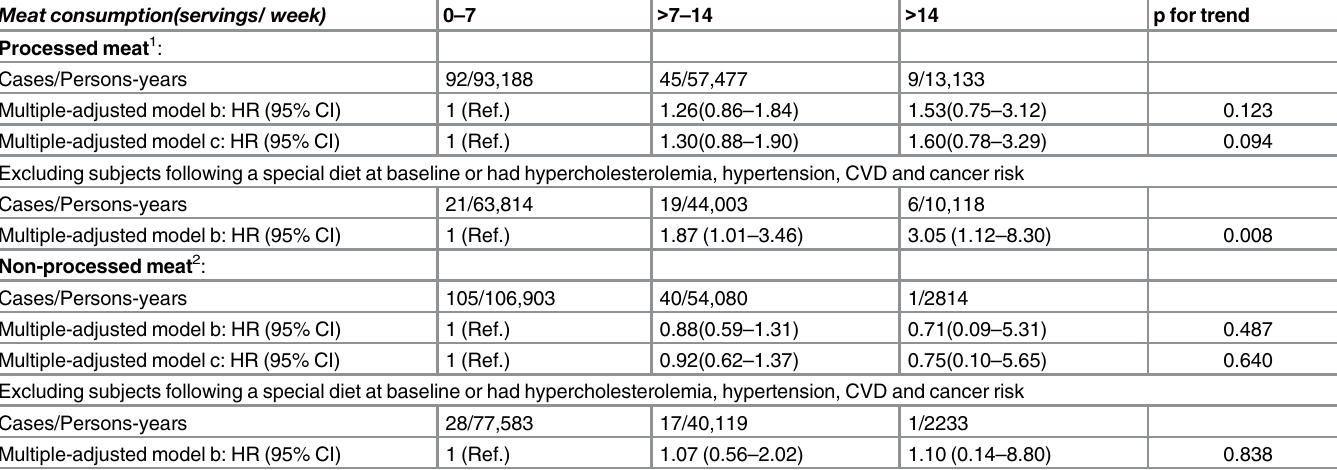
Table 3. HR and 95% CI for incident type 2 diabetes according to categories of processed and unprocessed meat consumption. The SUN Project 1999 – 2014.